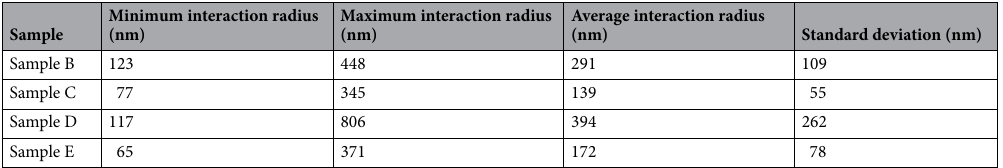
Table 2. Summary of the calculated interaction radius values for each